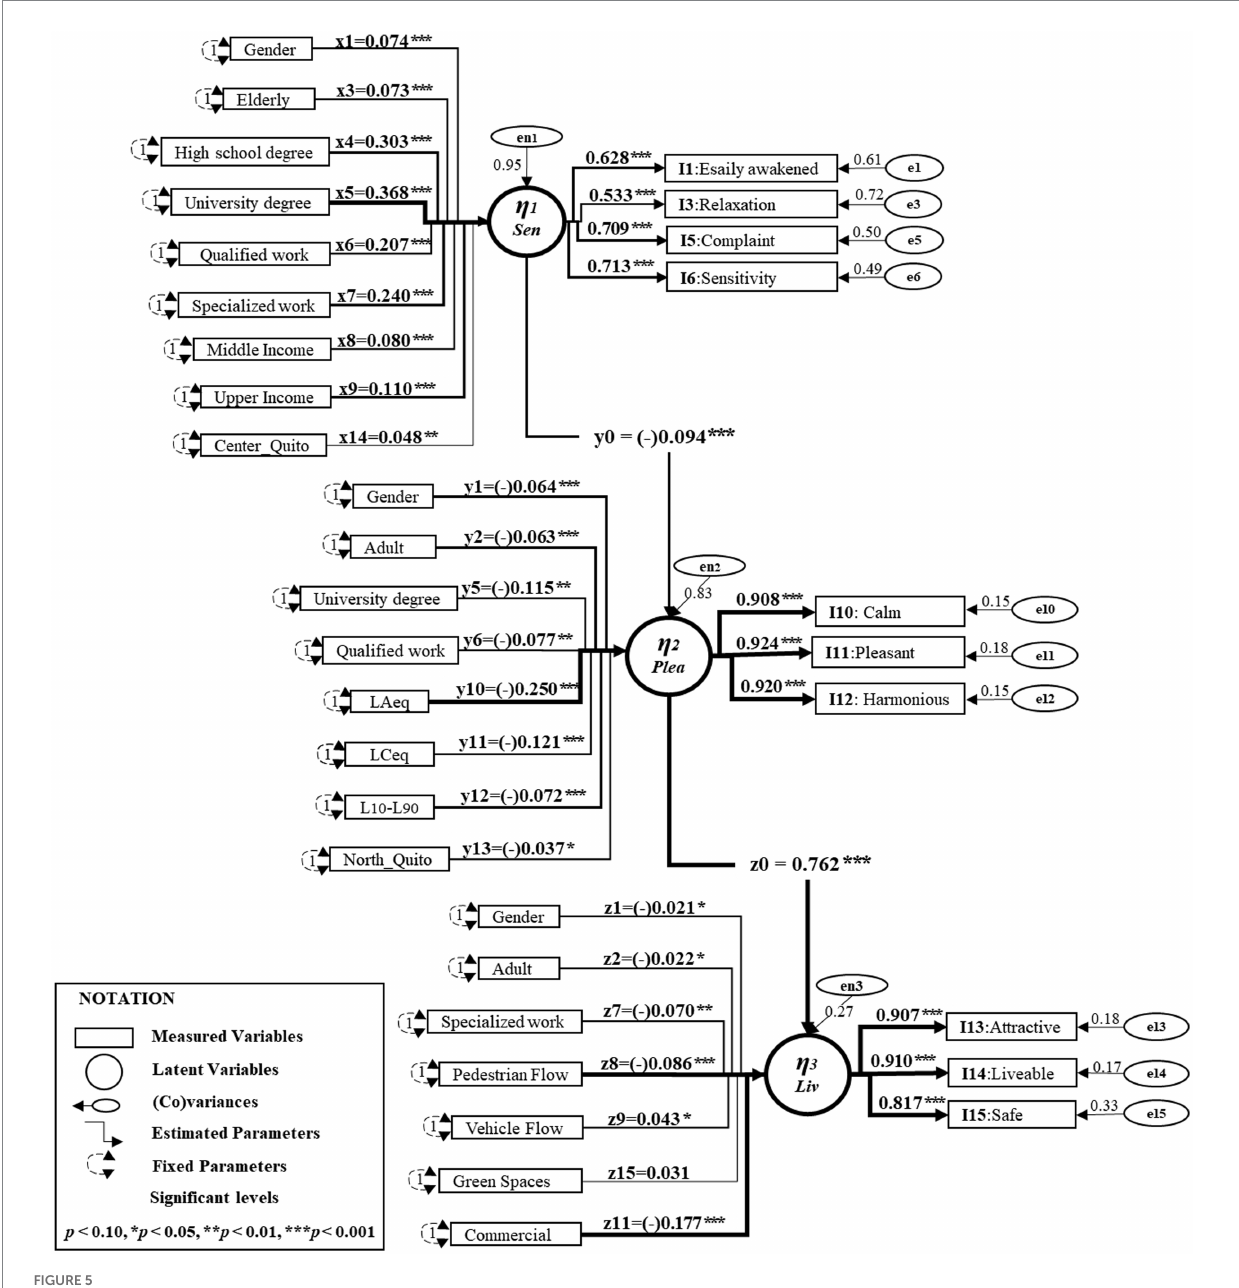
FIGURE 5 Results of the modified SEM